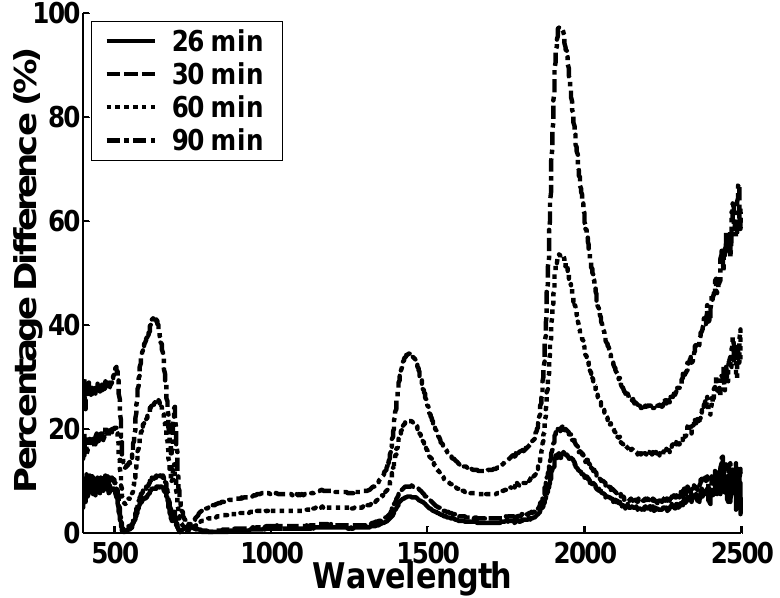
Figure 5 . Percentage differences along the electromagnetic spectrum region of 400–2500 nm for a Fagus sylvatica L. leaf under a tungsten halogen lamp for a period of 26, 30, 60, and 90 minutes. Changes in the reflectance values are detected with profound differences in the water absorption